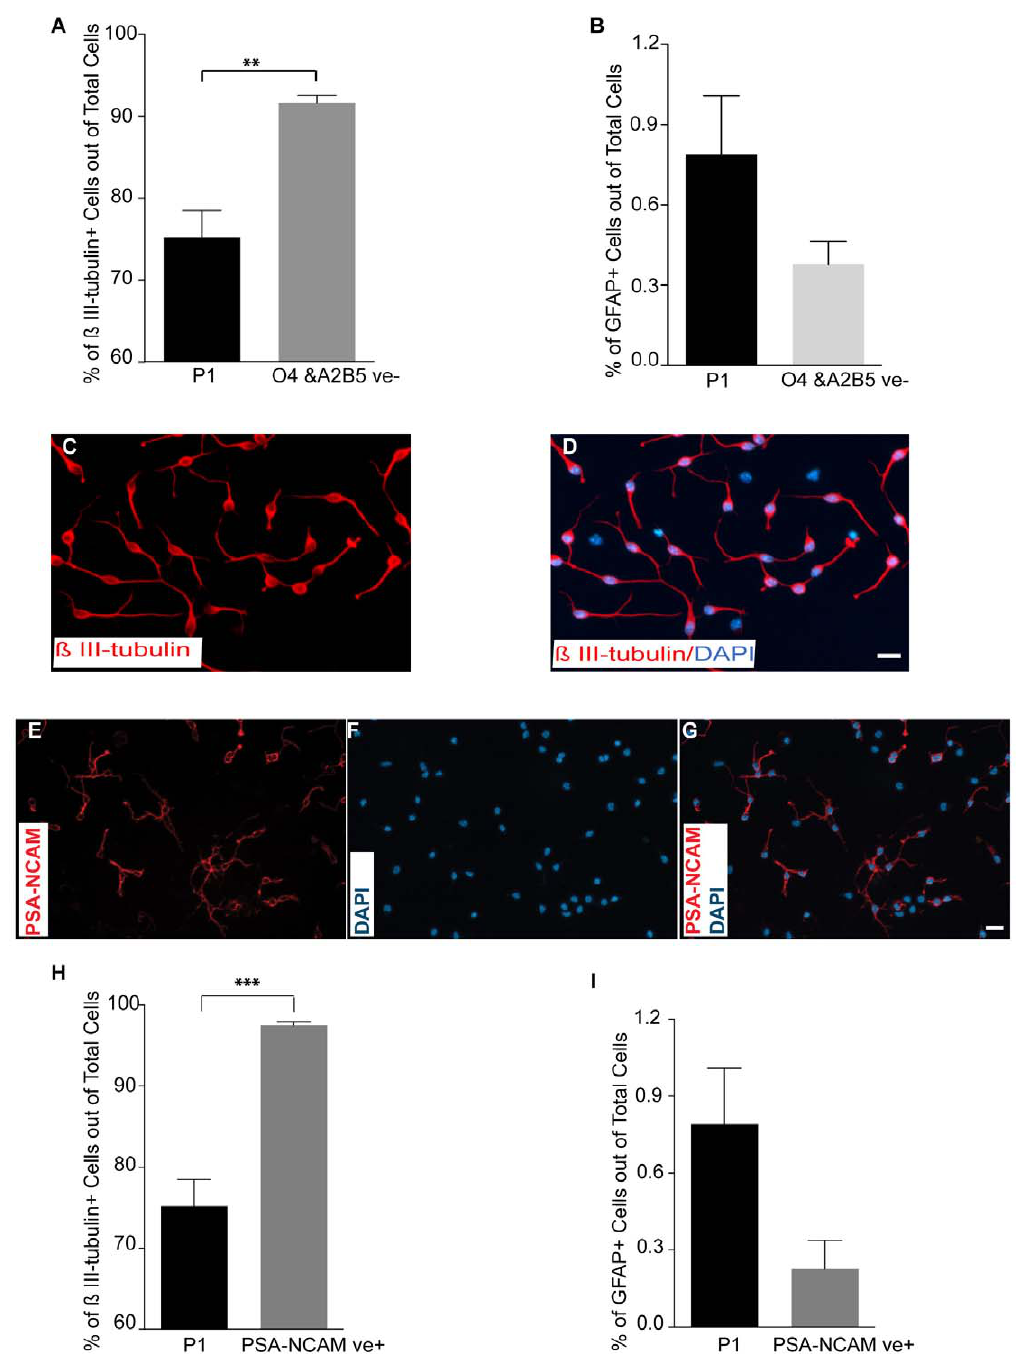
Figure 3. Negative and positive selection strategies to further improve neuronal cell enrichment. In order to achieve purer neuronal cell population, contaminating cells (O4 and/ A2B5 + cells) were excluded from P1 population or PSA-NCAM + cells were selected and isolated from the P1 population. ( A ): Comparison of the mean percentage of b III-tubulin IR cells from the sorted P1 vs. O4/A2B5 double excluded P1 cell population one day after plating. (mean 6 SEM; n=5 2 9 independent experiments; ** p=0.0038, Student’s t-test,). ( B ): Comparison of the mean percentage of GFAP IR cells in sorted P1 vs. O4/A2B5 double excluded P1 cell population one day after plating. (mean 6 SEM; n=5 2 9 independent experiments). ( C–D ): Micrographs from O4/A2B5 excluded P1 sorted cells showing that the majority of cells are b III-tubulin immunoreactive one day after sort. ( E–G ): PSA- NCAM staining on sorted cells from the P1 population one day after plating showing about 60% of sorted cells are PSA-NCAM IR. ( H–I ) Comparison of the mean percentage of b III-tubulin ( H ) and GFAP ( I ) positive cells in P1 and PSA-NCAM + P1 sorted cells one day after plating (mean 6 SEM; n=5 2 9 independent experiments, *** p=0.0004, Student t-test,). Scale bars=10 m m. Abbreviation: PSA-NCAM=Polysialic acid-neural cell adhesion molecule.